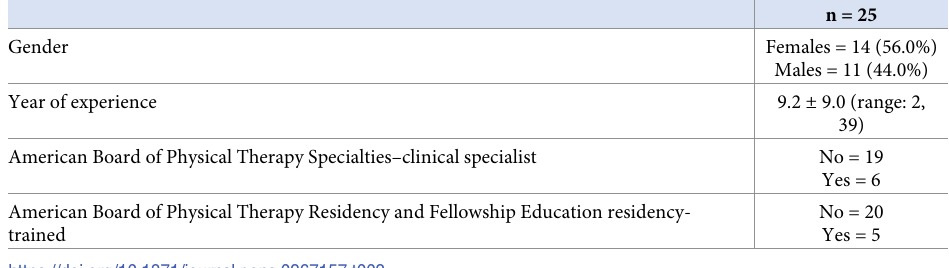
Table 2. Physical therapy descriptive data represented in means with standard deviations and proportions for cat- egorical